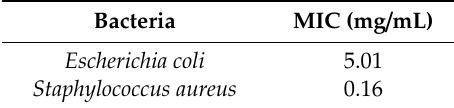
Minimal inhibitory concentration (MIC) (mg / mL) of resveratrol determined by microdilution method.